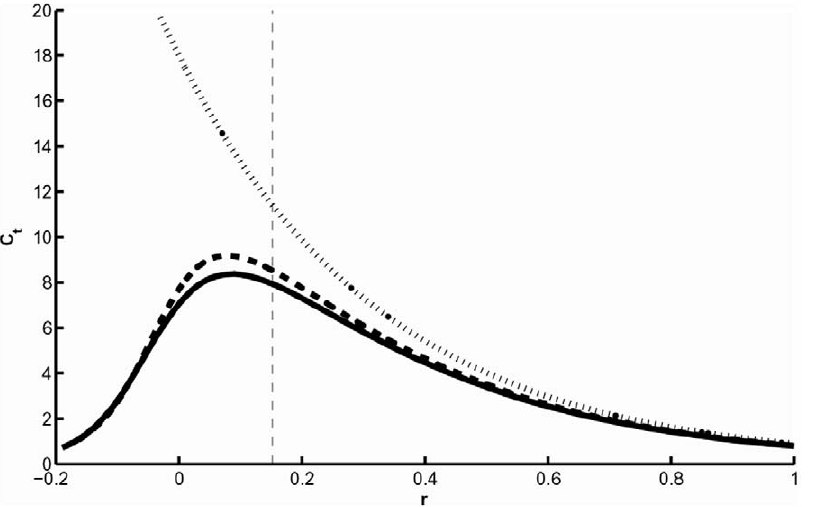
Figure 2. Vectorial capacity in a stable population for three mortality models (see Table 3 for functions). Parameters used in calculations are: exponential (dotted line, g =0.0313), Gompertz (dashed line, a =0.00662, b =0.06234), and logistic (solid line, a =0.00662, b =0.06234, s =1.073); taken from Styer et al. 2007a.